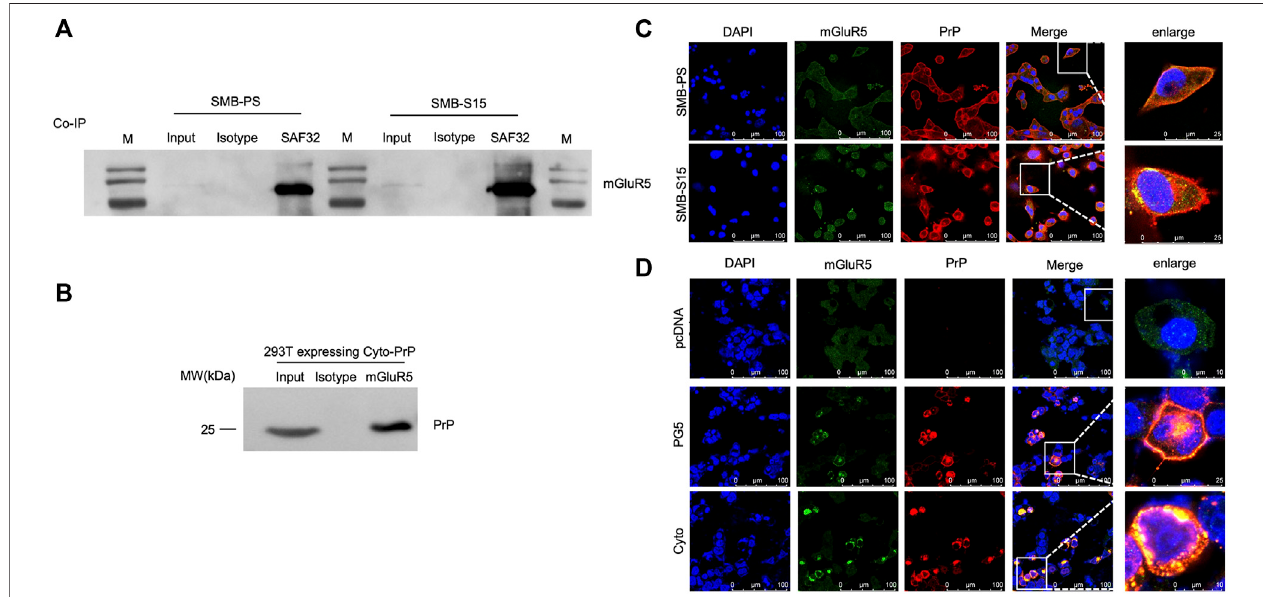
FIGURE 2 | Molecular interaction and morphological colocalization between PrP and mGluR5. (A) Immunoprecipitation assays for the complexes of PrP and mGluR5intheSMB-PSand -S15cell. Thecelllysateswere precipitated withantibodies against PrP(SAF32),mouseIgGand weresubsequently evaluatedbymGluR5- speci fi c Western blots. An aliquot of cell lysates (marked as input) was directly loaded into SDS-PAGE as controls. Two SMB cell lines are indicated above. (B) Immunoprecipitation assays for the complexes of PrP and mGluR5 in the 293T cell transiently expressing Cyto-PrP. The cell lysates were precipitated with antibodies against mGluR5 and mouse IgG were subsequently evaluated by PrP-speci fi c Western blots. An aliquot of cell lysates (marked as input) was directly loaded into SDS-PAGE as controls. (C) Immuno fl uorescent assays of the co-localization between PrP and mGluR5 in SMB cells with confocal microscopy. Two SMB cell lines aremarkedontheleft. (D) Immuno fl uorescentassaysoftheco-localizationbetweenPrPandmGluR5in293Tcelltransientlyexpressingwild-typehumanPrP(PG5-PrP) and Cyto-PrP with confocal microscopy. Various transfected 293T cells are marked on the left. The images of DAPI (blue), mGluR5 (green), PrP (red), and merge are indicated above. The magni fi cation views are shown on the right each